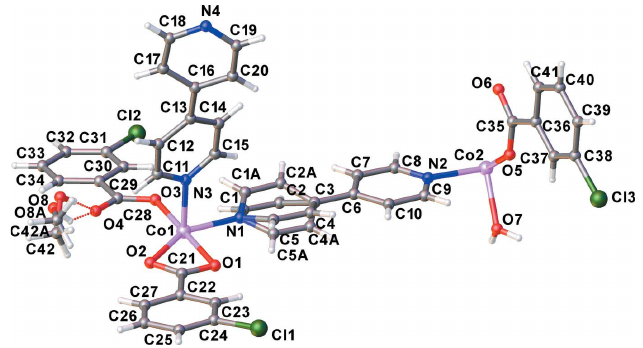
Figure 1 Asymmetric unit of the title compound with the atom labelling. Displacement ellipsoids are drawn at the 50% probability level.